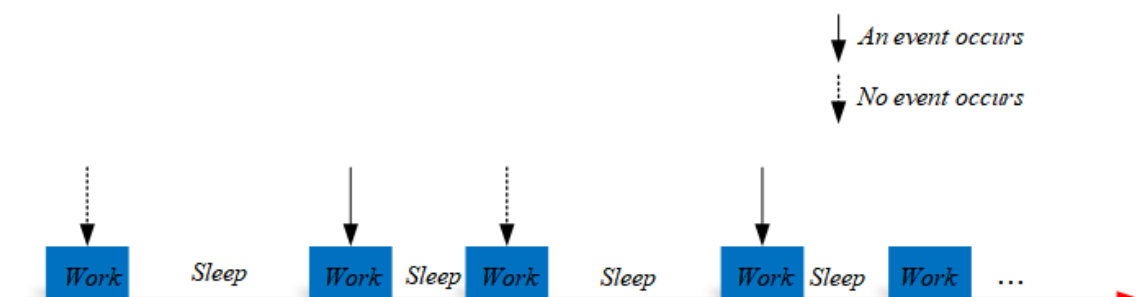
Figure 2. The diagram of alternate sensing